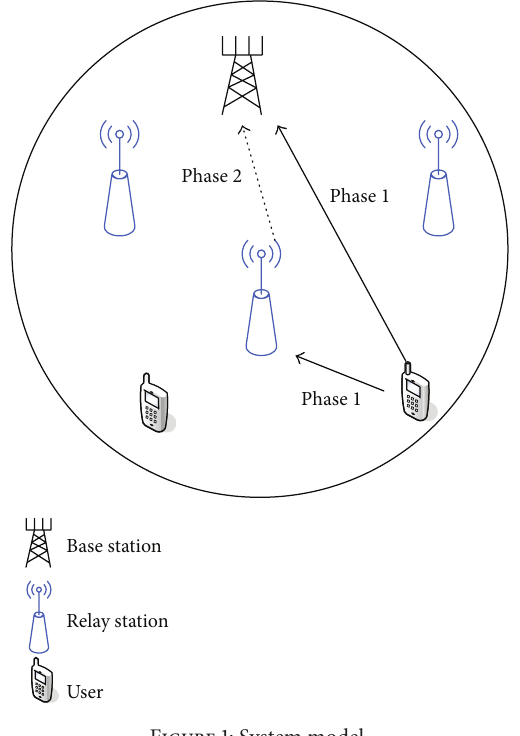
Figure 1: System